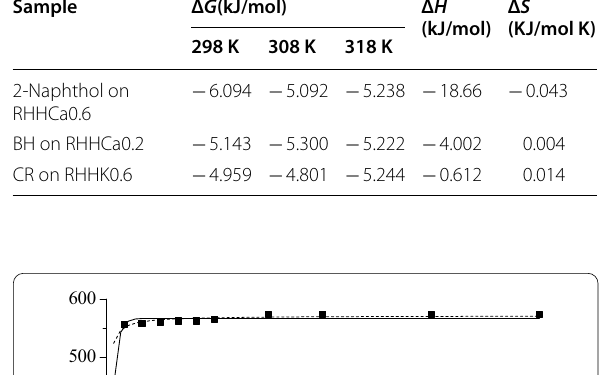
Table 3 Adsorption thermodynamic parameters of the three organics on the selected hydrochars Sample